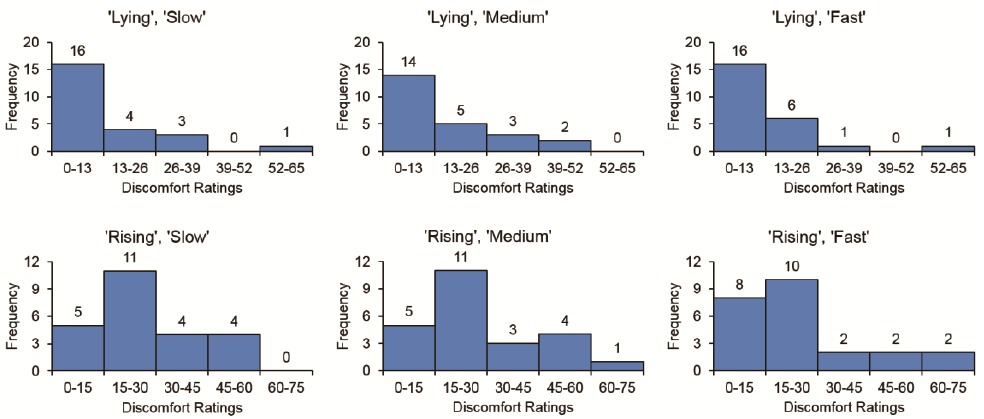
Figure 5. Histogram of frequency distribution of discomfort ratings caused by backrest adjustment.